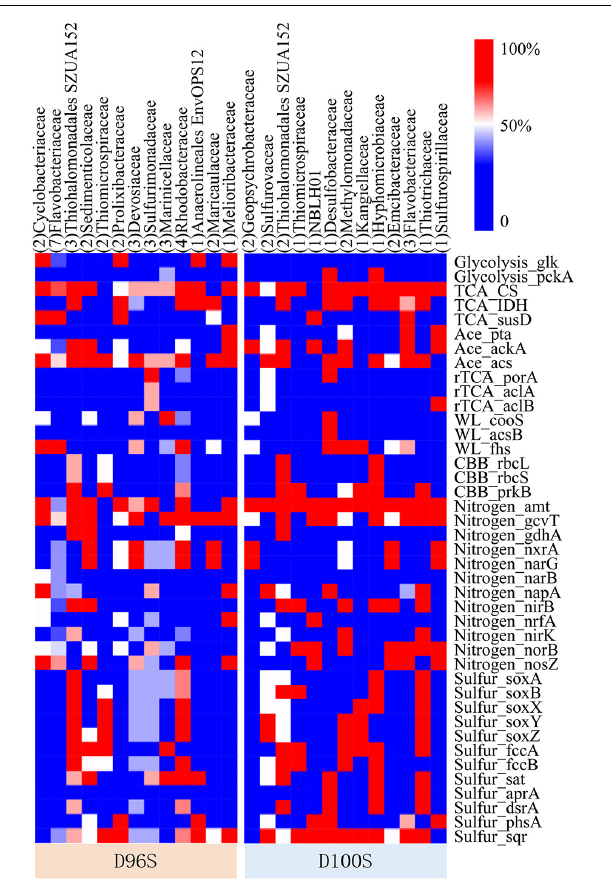
FIGURE 5 | Frequency of functional genes identified in metagenome-assembled genomes (MAGs) belonging to different families. The functional genes of 57 good-quality MAGs were identified by searching against Kyoto Encyclopedia of Genes and Genomes (KEGG) database. The number of MAGs in each genome taxonomy database (GTDB) family was included in the round brackets. The functions of the genes are shown in Supplementary Table 5 . The full annotation of KEGG functions is shown in Supplementary Table 6